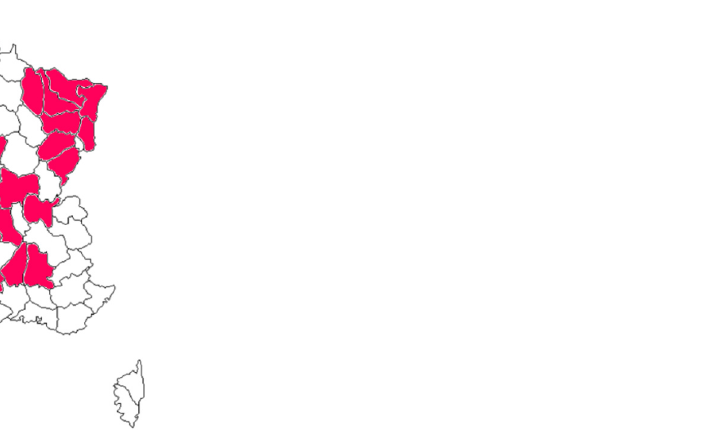
Figure 1. Geographical distribution of the sampled cattle from breeding areas throughout the country.